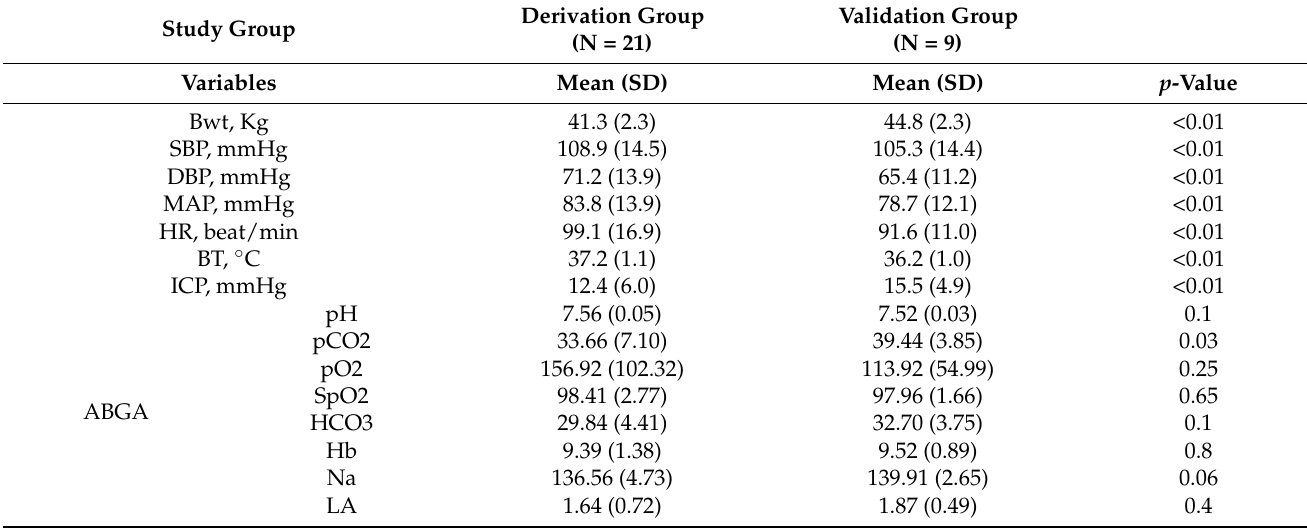
Table 1. Baseline characteristics of study subjects according to derivation and validation group.